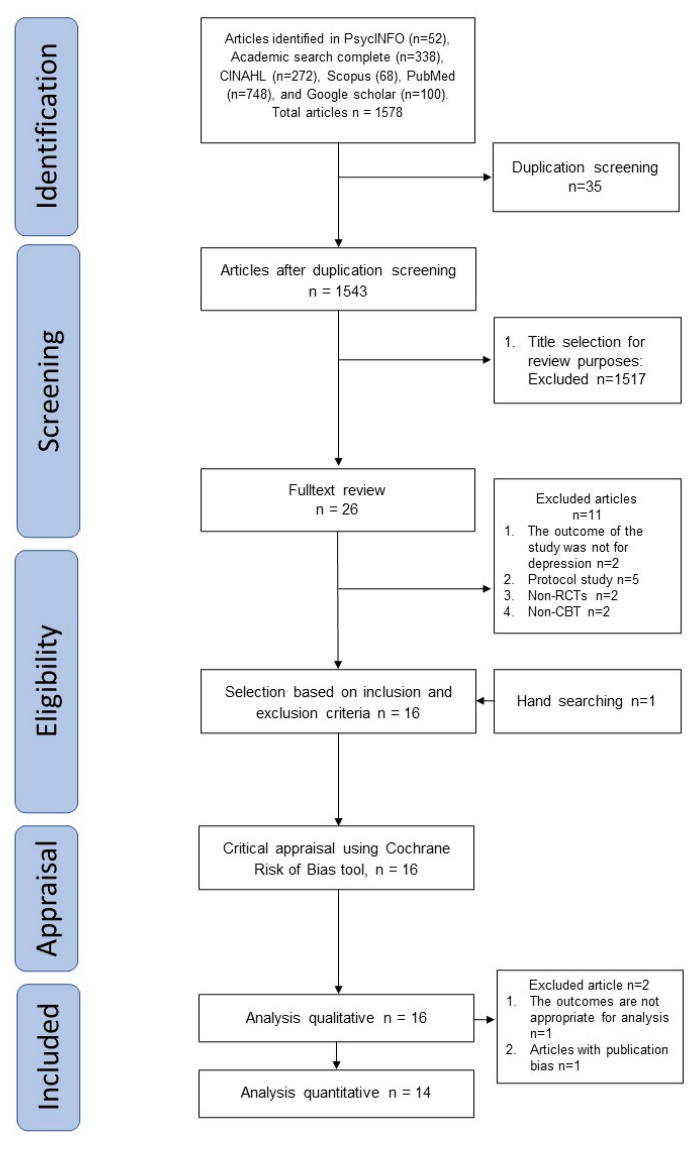
Figure 1. PRISMA flow diagram.